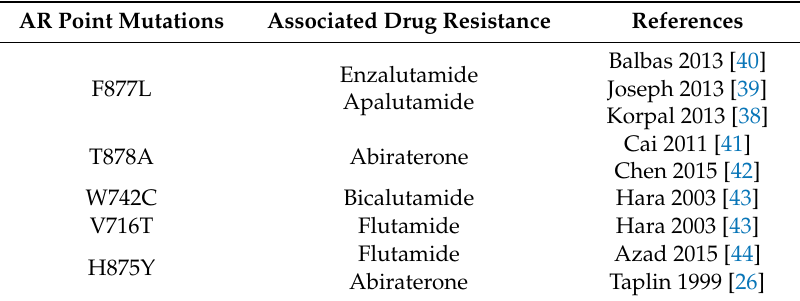
Table 1. Most common androgen receptor (AR) mutations in prostate cancer and associations with drug